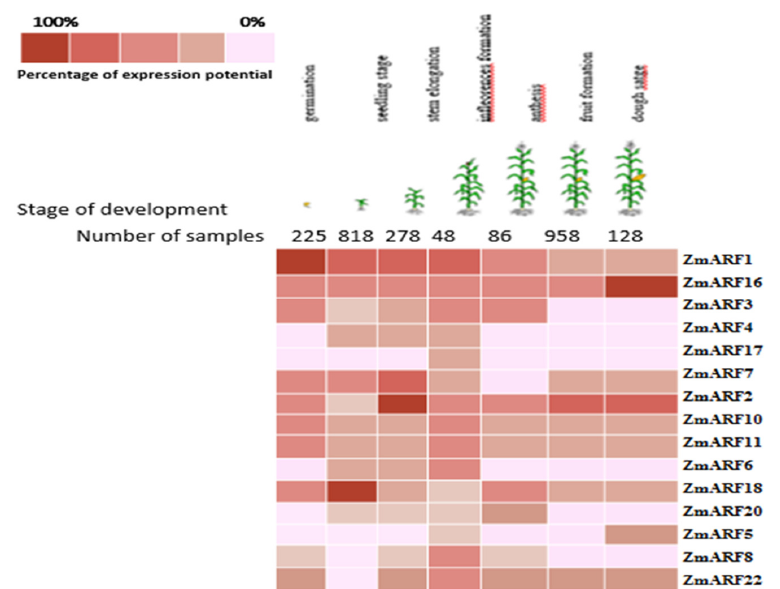
Figure 4b . Heatmap analysis of expression of ZmARF genes at different developmental stages of Z.